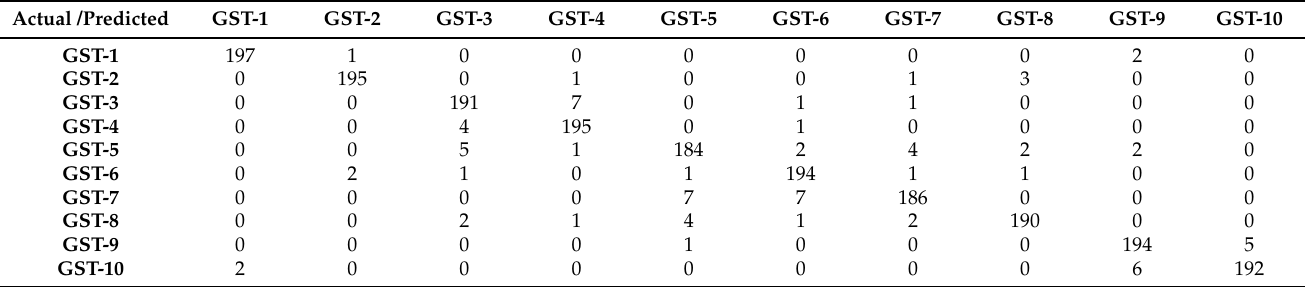
Table 9. Confusion matrix of random forest with accuracy